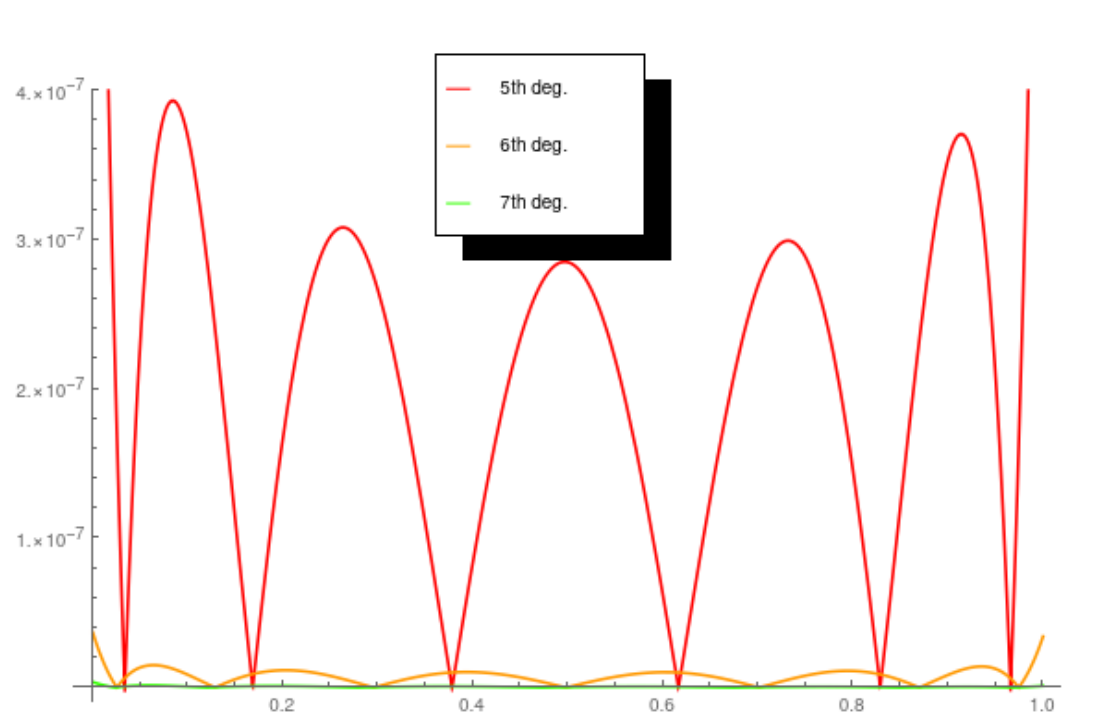
Figure 2. The absolute errors of the 5th, 6th and 7th degree PLSM approximations for problem